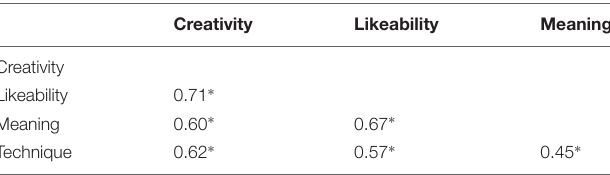
TABLE 3 | Pearson’s correlation coefficients for creativity, likeability, meaning and technique